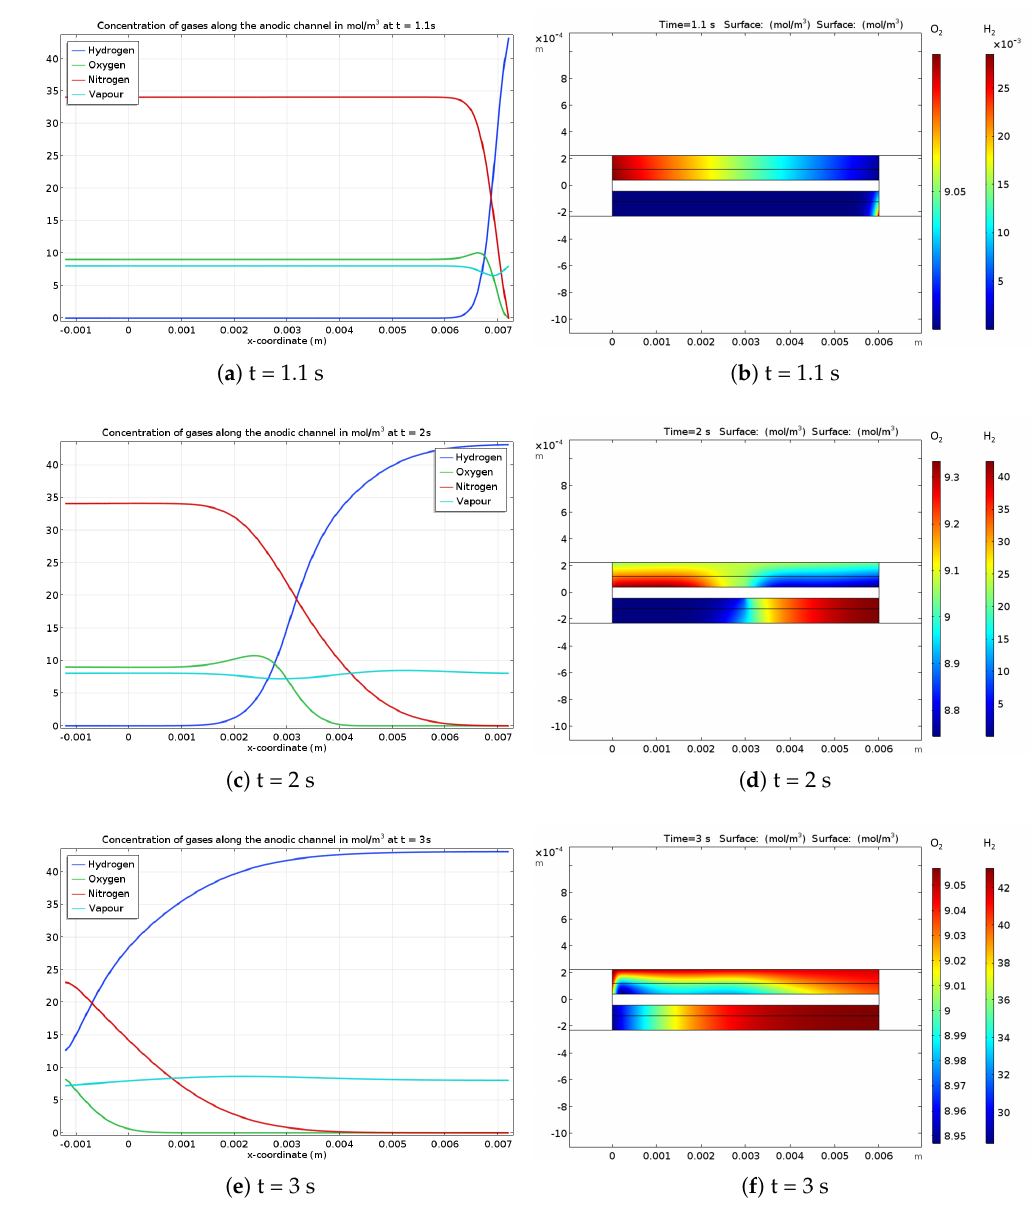
Figure 2. Gases concentration along the anodic channel ( a , c , e ) and in the GDL ( b , d , f ) with oxygen (top) and hydrogen (bottom) during different phases of startup: ( a , b ) 1.1 s, ( c , d ) 2 s and ( e , f ) 3 s. It should be noted that the channels coordinates go from − 0.001 m to 0.007 m (0.008 m length), whereas the active zone (including GDL and CL) goes only from (0.001 m to 0.006 m. The longer channels allow to homogenize the gas flow outside of the active zone, especially at the